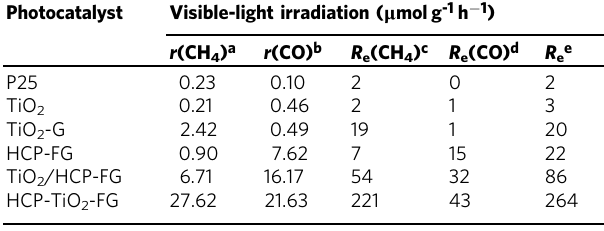
Table 1 Summary of the photocatalytic CO 2 conversion ef fi ciency during 5 h of constant irradiation